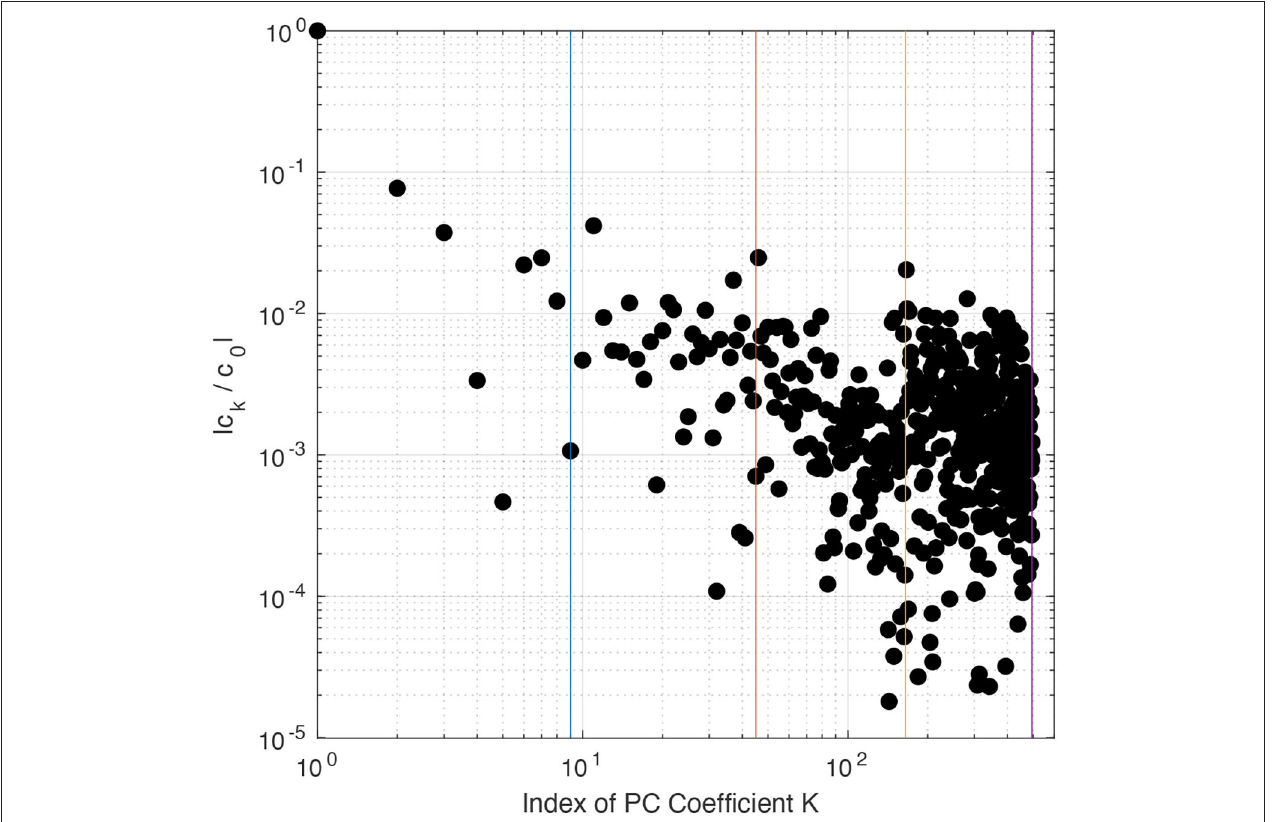
FIGURE 2 | PCE normalized coefficients c k /c 0 for PC of order up to r = 4. Vertical lines separate the PCE terms into their different PC orders. PCE coefficients were calculated using the basis pursuit denoising (BPDN) method.